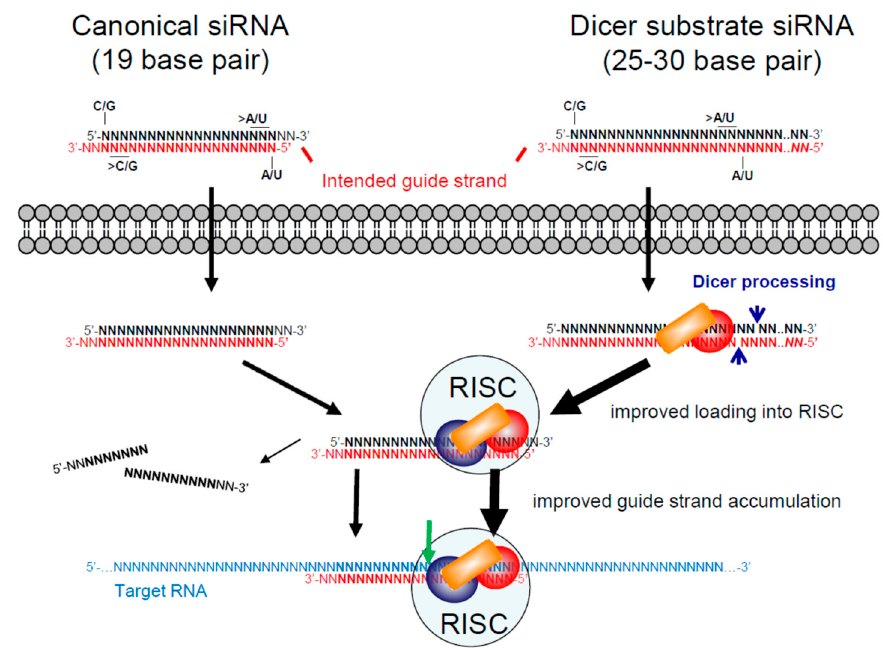
Figure 3. Canonical and Dicer substrate siRNA designs. On the top left, the typical or canonical siRNA design of 19 base pairs with two-nucleotide overhangs on the ends is illustrated. To ensure that the intended guide strand (red) is selected by the RNA induced silencing complex (RISC), siRNAs should have higher G/C content at the 3 ′ end of the intended guide strand and higher A/U content at its 5 ′ end, in particular for the terminal nucleotides. On the top right, Dicer substrate siRNA designs of 25 to 30 base pairs are illustrated. They have been designed both in symmetrical two-nucleotide overhang formats and with a 5 ′ blunt end ( NN) on the intended guide strand. Both canonical and Dicer substrate siRNAs use the RISC to cleave their target RNA (green arrow). By first recruiting the Dicer enzyme complex, Dicer substrate siRNAs may improve loading of siRNAs into the RISC and improve preferential selection of the guide strand.